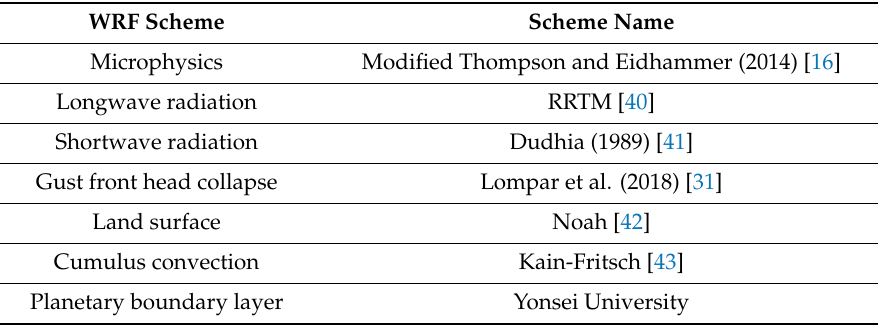
Table 1. WRF physics packages used in this